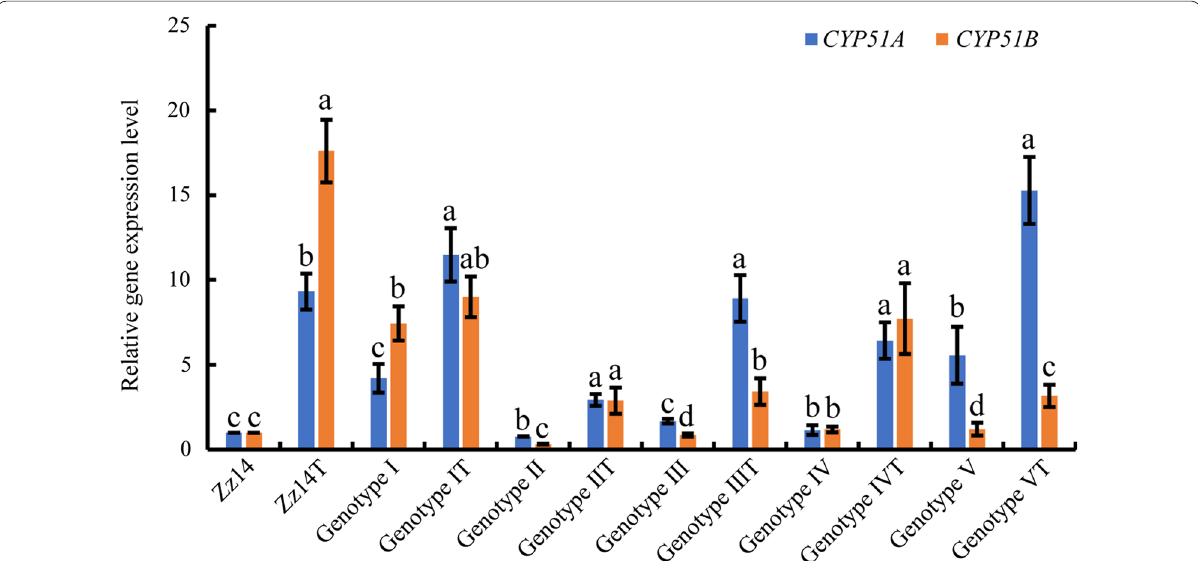
Fig. 8 Determination of constitutive and tebuconazole-induced expression levels of CYP51A and CYP51B in tebuconazole-sensitive isolates and the replacement mutants of five genotypes. The tebuconazole-sensitive isolates and replacement mutants were treated with 10 mg/L tebuconazole or left untreated. Error bars denote the standard deviations from three repeats. The significant difference was compared between the untreated and its corresponding treated groups. Different letters indicate significant differences according to the Fisher’s LSD test at P